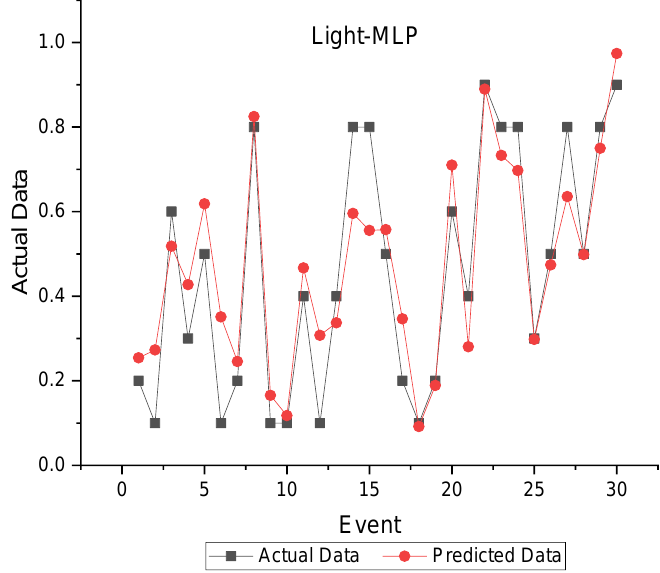
Figure 18. Representation of actual and prediction data for light MLP.